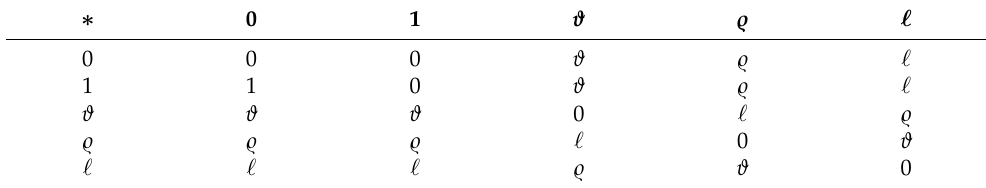
Table 2. Cayley’s table for ∗